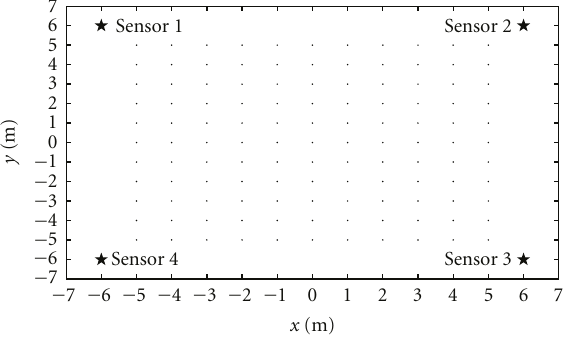
Figure 3: Sensor allocation and reference